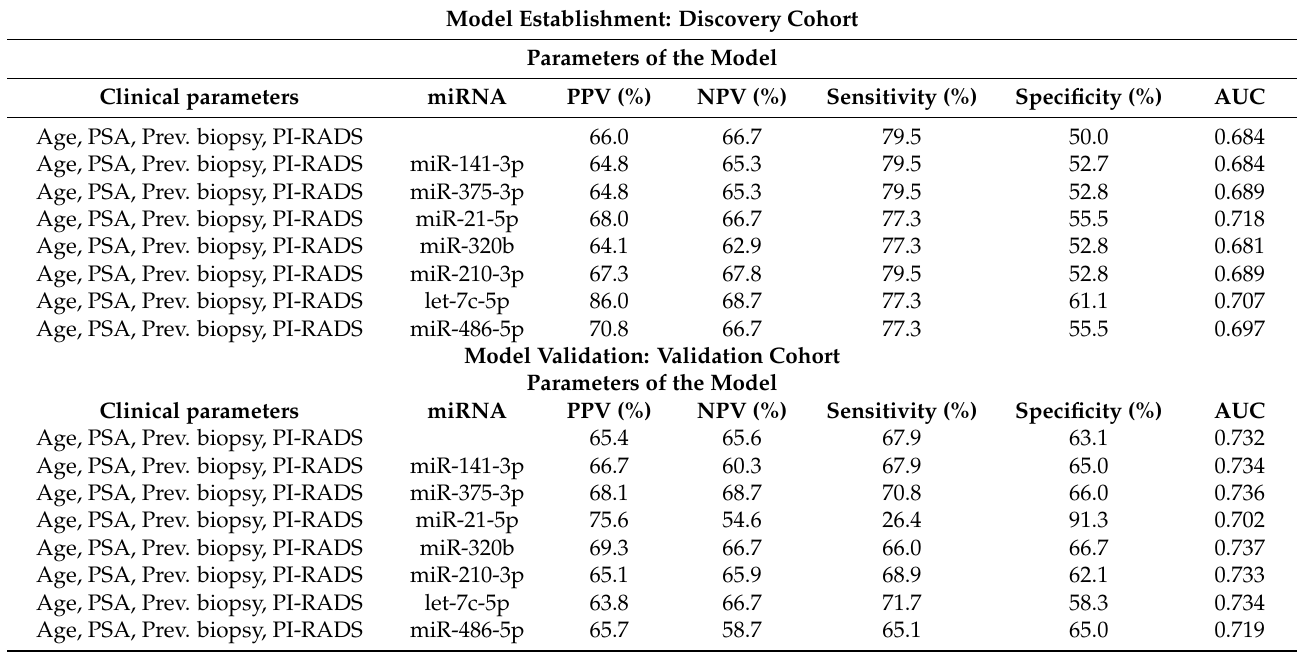
Table 2. Predictive performance of clinical parameters and miRNAs in the discovery and validation cohorts.